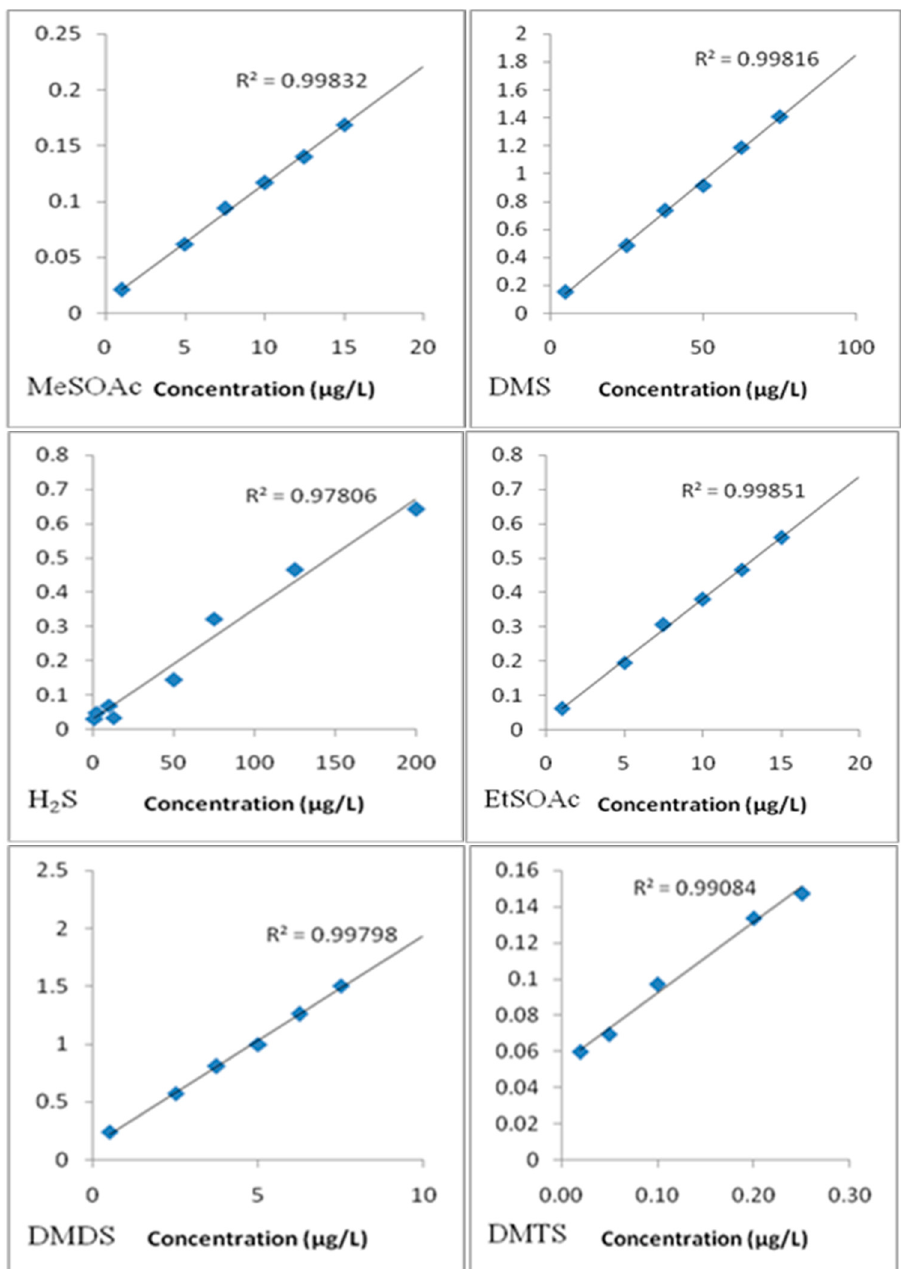
Figure 7. Calibration curves for some sulfur standards; y-axis = ratio of S:IS response (sqrt(peak area)); DMS (IS = EMS); DMDS, MeSOAc, EtSOAc (IS = DES); H 2 S, MeSH, DEDS, and DMTS (IS = DIDS).